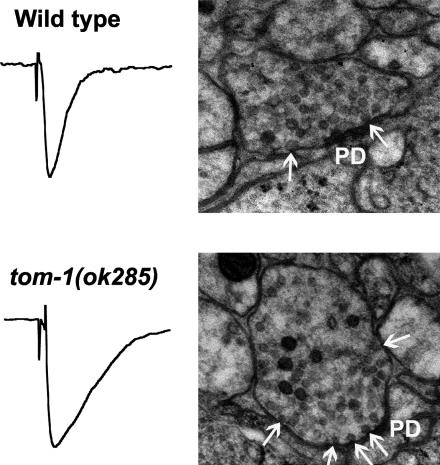
Electron micrographs of rapidly fixed worm synapses reveal differences in synaptic vesicle localization in tomosyn mutants versus wild type.